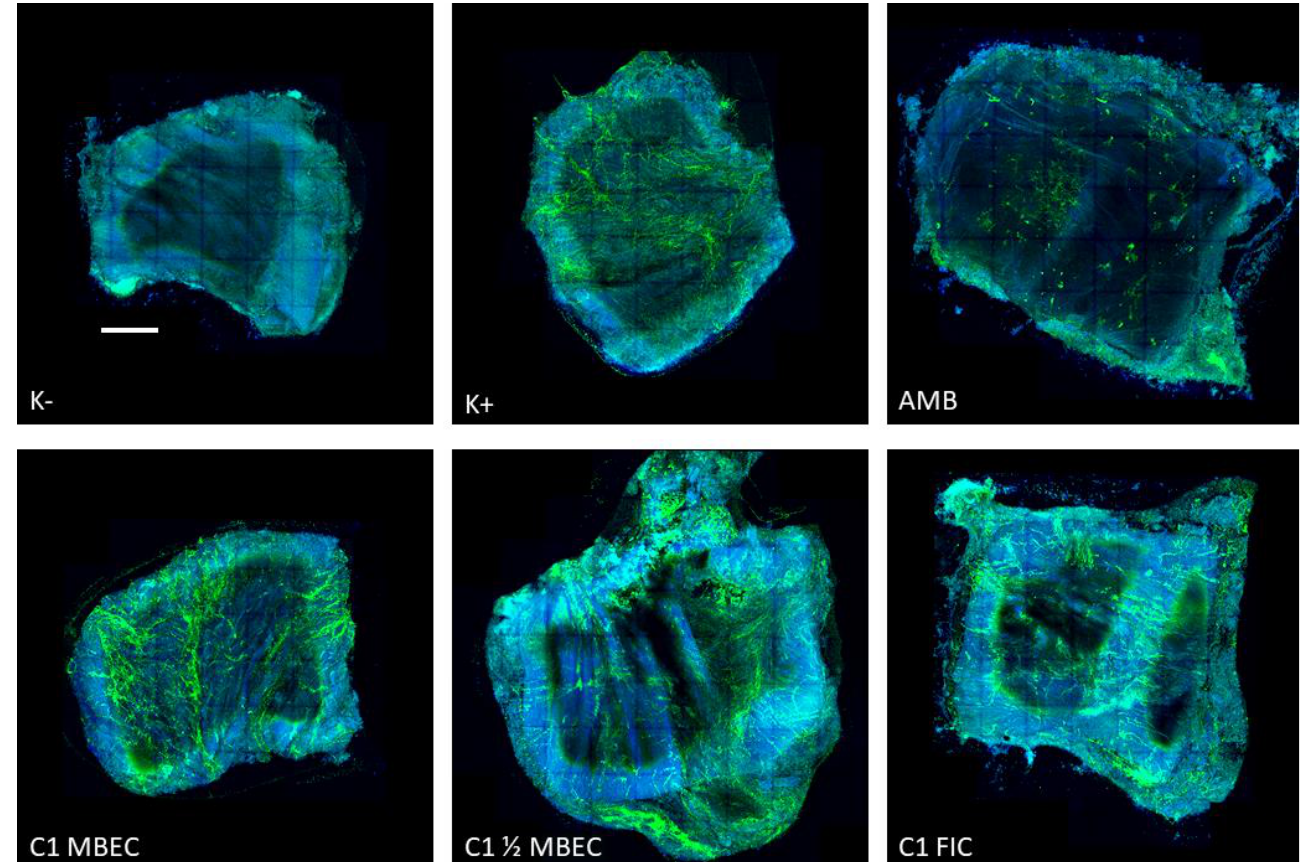
Figure 3. An exemplary set of experiments in confocal microscopy. Green color shows C. albicans based on Calcofluor staining, and blue labels the vaginal epithelium based on Evans Blue dye. Mature biofilm of C. albicans CA2 treated with: AMB — amphotericin B (50 µg/mL) and cyclic lipopeptide C1 at a concentration equal to MBEC, ½ MBEC, and FIC. K(-) and K(+) are referred to as negative and positive controls (MBEC — minimum biofilm eradication concentration; FIC — fractional inhibitory concentration). Scale bar = 1 mm.